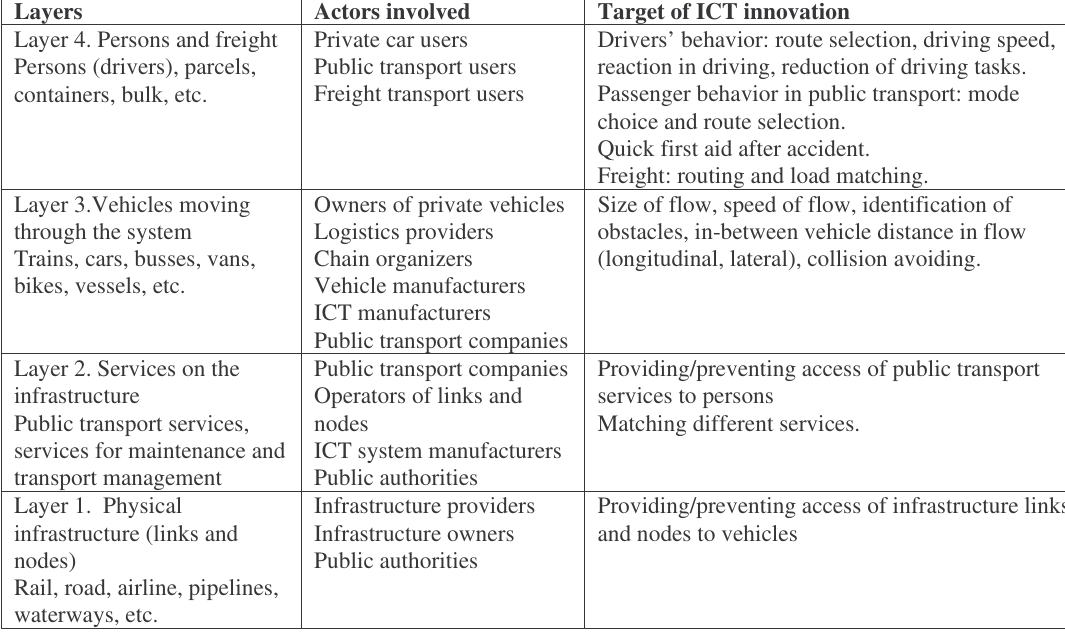
Figure 2. A simplified layer model of the transport